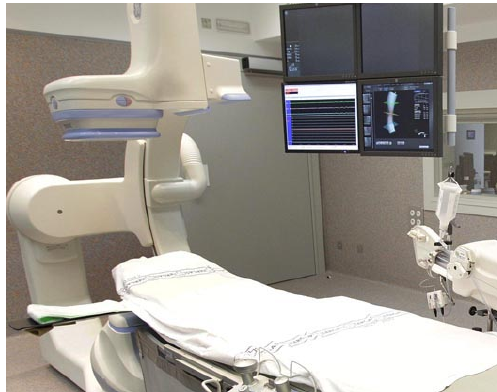
Figure 1. Álvaro Cunqueiro Hospital Cath